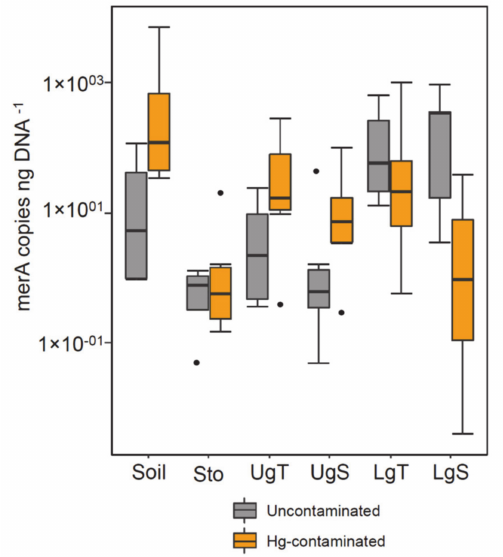
Figure 1. Mercury reductase A gene (merA) abundance across the soil and earthworm gut parts for uncontaminated and Hg-contaminated treatments (experiment 2). Sto = stomach, UgT = upper gut tissue, UgS = upper gut soil, LgT = lower gut tissue, LgS = lower gut